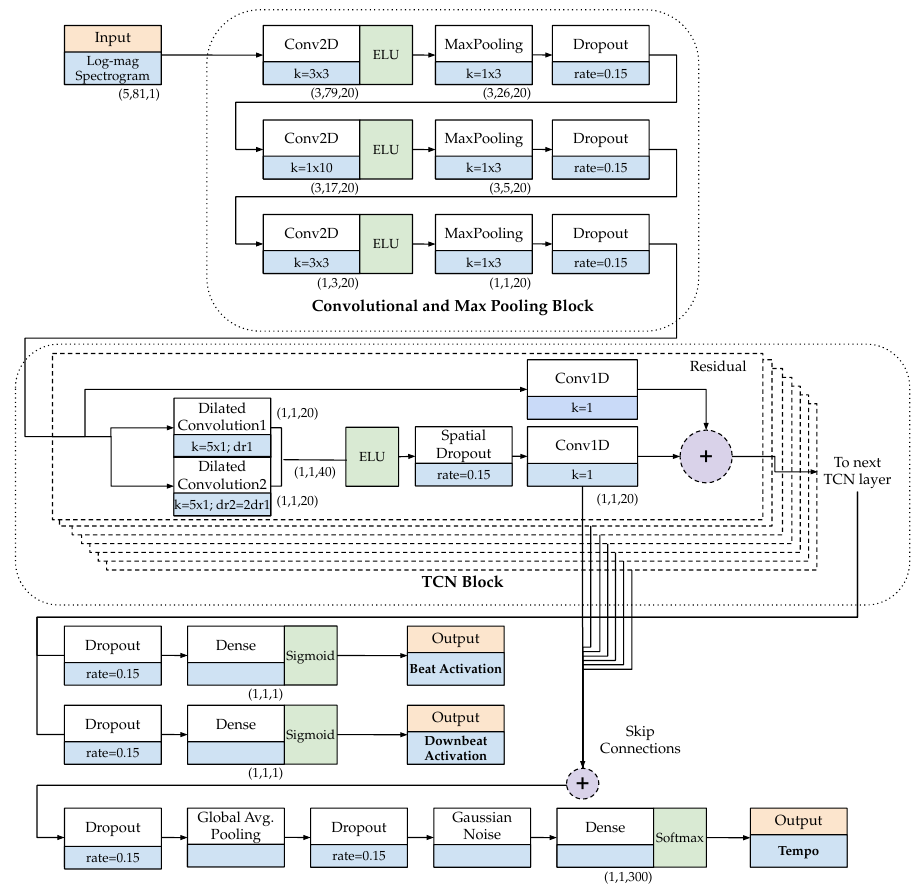
Figure 2. Overview diagram of the architecture of the baseline beat-tracking approach. The training was conducted using eight-fold cross validation (6 folds for training, 1 fold for validation, and 1 fold held-back for testing), with excerpts from each dataset uniformly distributed across the folds. A maximum of 200 training epochs per fold were used with a learning rate of 0.002, which was halved after no improvement in the validation loss for 20 epochs, and early stopping was activated with no improvement after 30